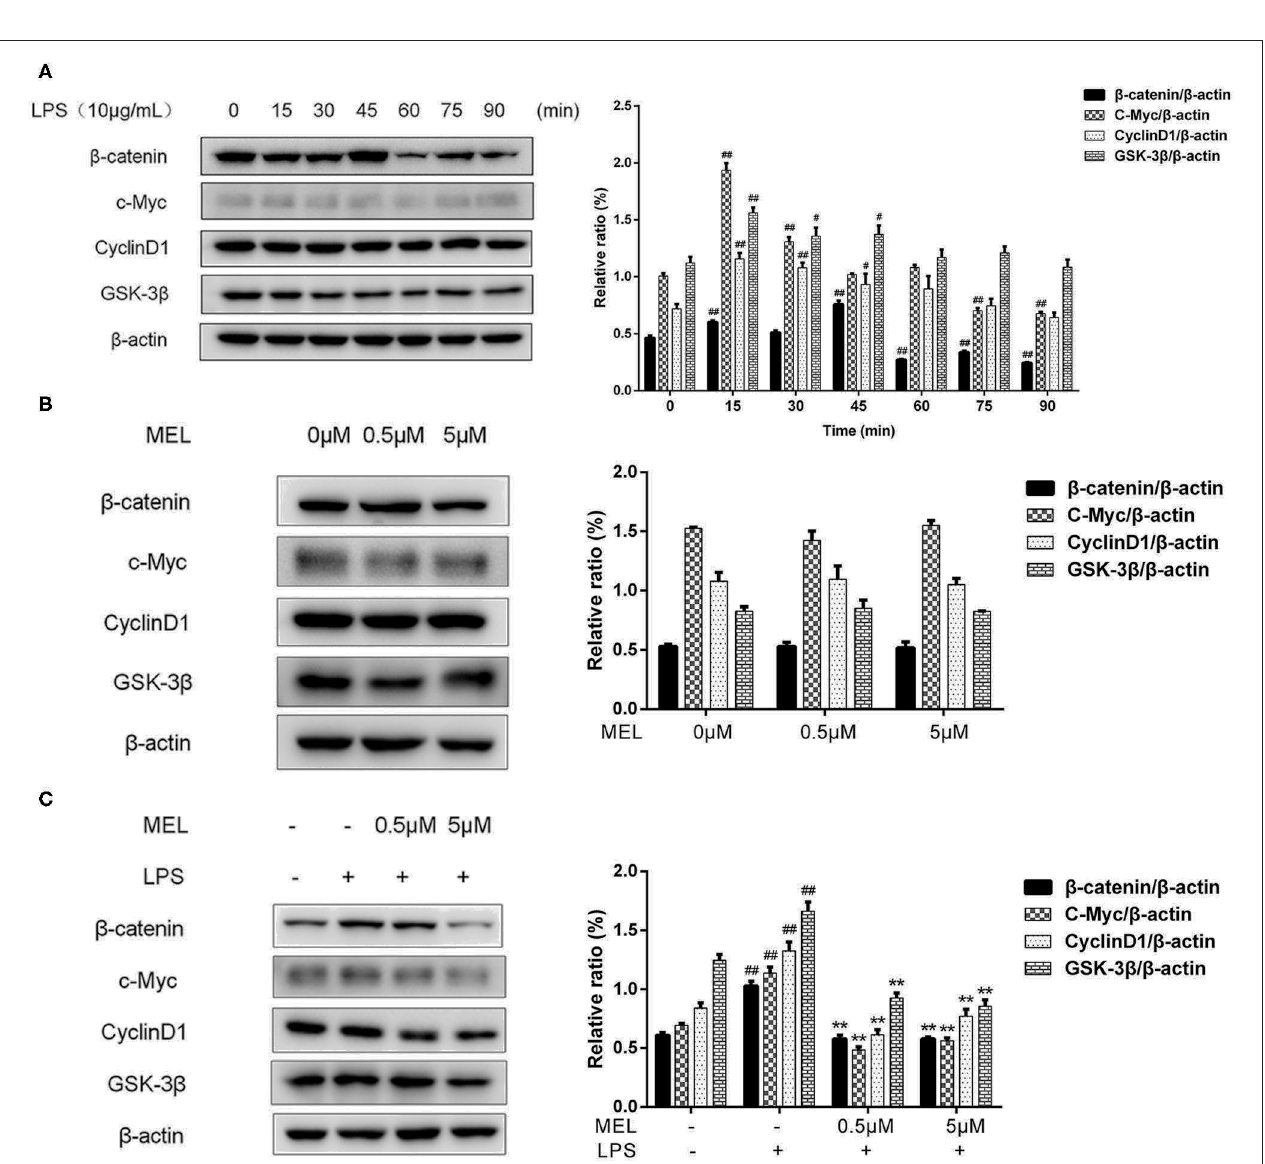
FIGURE 9 | The effect of meloxicam on the Wnt/ β -catenin pathway in bovine endometrial epithelial cells. The protein levels of β -catenin, c-Myc, cyclin D1, and GSK-3 β were determined using western blot. The band intensity quantification was analyzed by Quantity One software. β -Actin was used as the internal control. LPS, lipopolysaccharide; MEL, meloxicam. (A) The cells were treated with LPS for 0, 15, 30, 45, 60, 75, and 90min. (B) The cells were treated with MEL alone for 15min. (C) The cells were treated with LPS or co-treated with LPS and MEL (0.5 and 5 µ M) for 15min. # P < 0.05, difference compared with the control; ## P < 0.01, difference compared with the control; * P < 0.05, difference compared with the LPS treatment group; ** P < 0.01, difference compared with the LPS treatment group. All data were presented as means ± SEM ( n = 3).